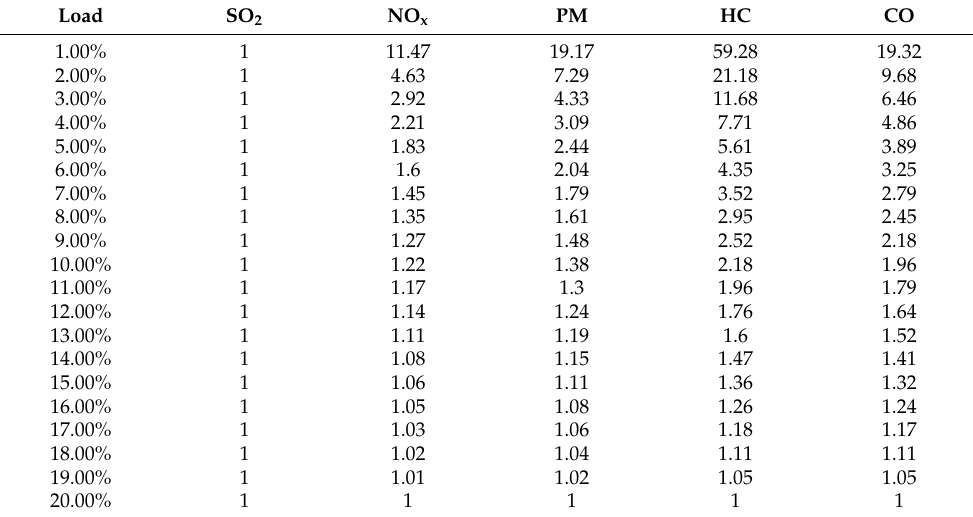
Table A1. Correction Multiplier of Emission Factors.